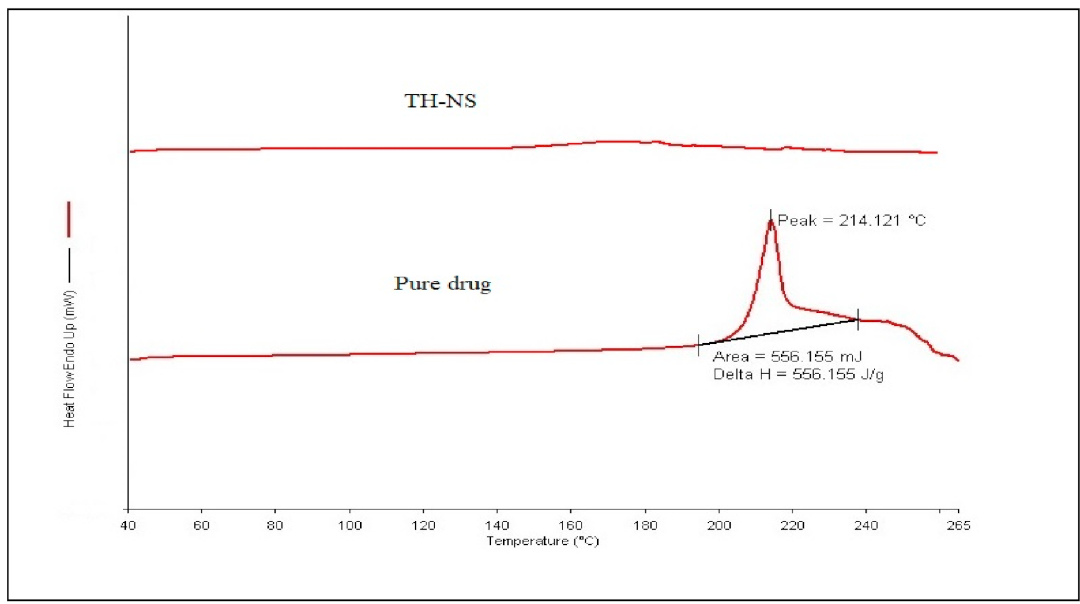
Figure 4. DSC thermogram of pure drug and TH-NS.